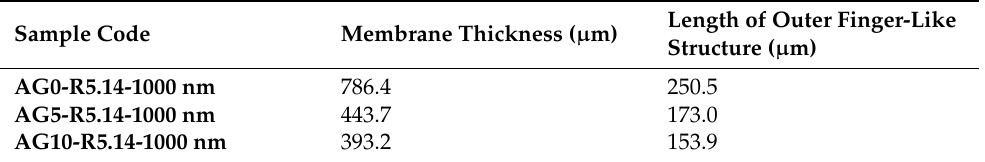
Table 2. The effect of the air gap distance on the membrane thickness.